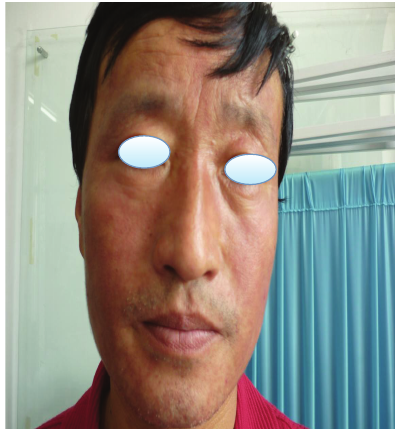
Figure 3: The lesions completely